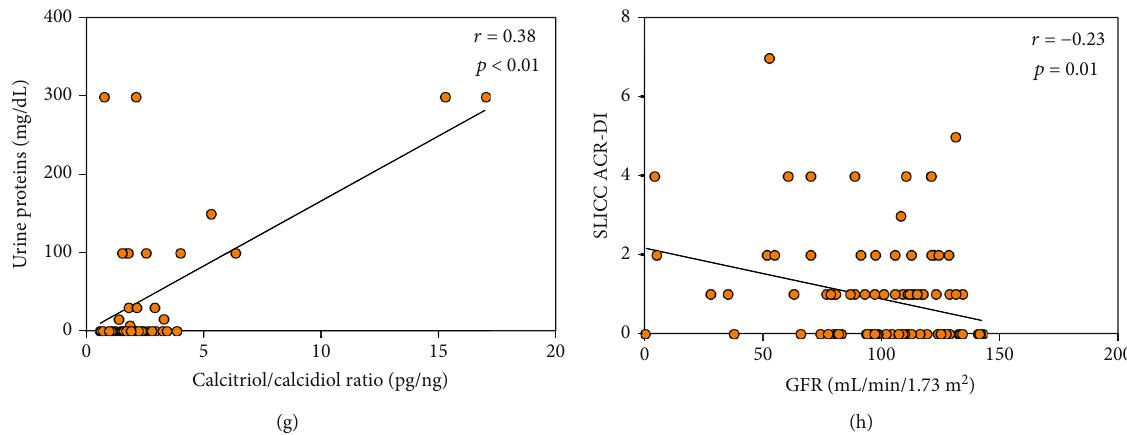
Figure 4: Correlations of vitamin D metabolite serum levels and vitamin D hydroxylation e ffi ciency ratio with clinical and renal variables in SLE patients. (a) Correlation of calcidiol serum levels and calcitriol serum levels; (b) correlation of calcidiol serum levels and urine proteins; (c) correlation of calcidiol serum levels and serum calcium; (d) correlation of serum calcium and Mex-SLEDAI; (e) correlation of calcitriol serum levels with blood lymphocyte count; (f) correlation of calcitriol serum levels and GFR; (g) correlation of calcitriol/calcidiol ratio and urine proteins; (h) correlation of GFR with the SLICC ACR-DI score. r : Spearman ’ s correlation coe ffi cient; GFR: glomerular fi ltration